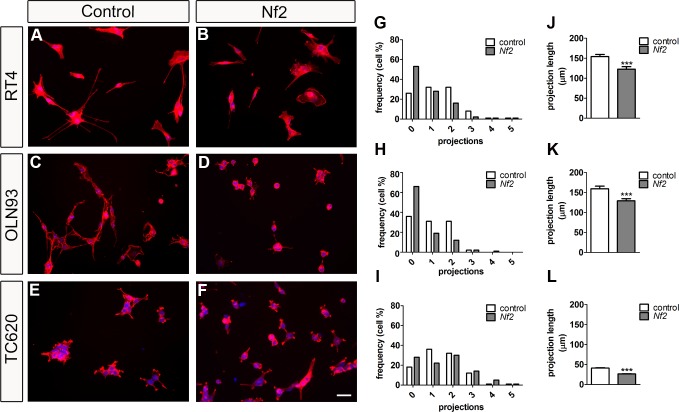
Merlin expression affects cell morphology.Nf2-transfected and control vector-transfected cell lines—RT4, OLN93 and TC620—were stained with phalloidin (actin cytoskeleton, red) and Hoechst 33342 (nuclei, blue) (A-F). Scale bar: 50 μm. Numbers of projections per cell are shown in G, H, and I as frequency distribution plots. Lengths of projections are shown in J, K, and L (mean ± SEM). Nf2-transfected RT4 and OLN93 cells contain significantly less processes as control-transfected cells (p < 0.01, Kolmogorov-Smirnov). Lengths of processes are significantly reduced in all cell lines (***p < 0.001, t-test; equal variances were tested by Levene’s test).